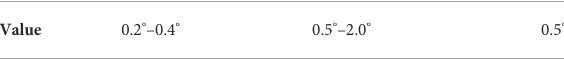
TABLE 2 The speci fi c accuracy of HI